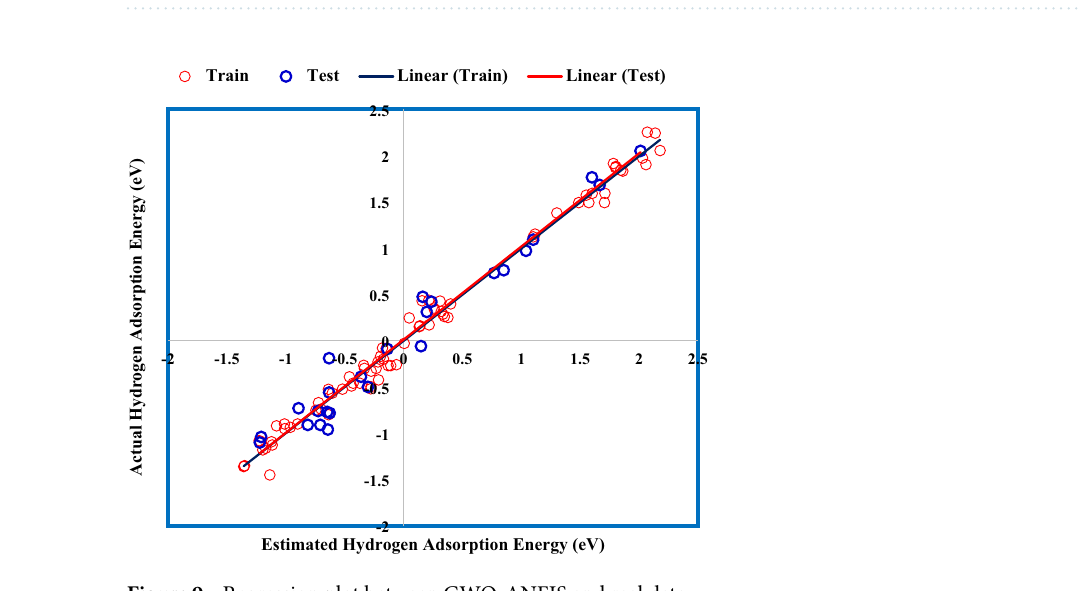
Figure 9. Regression plot between GWO-ANFIS and real